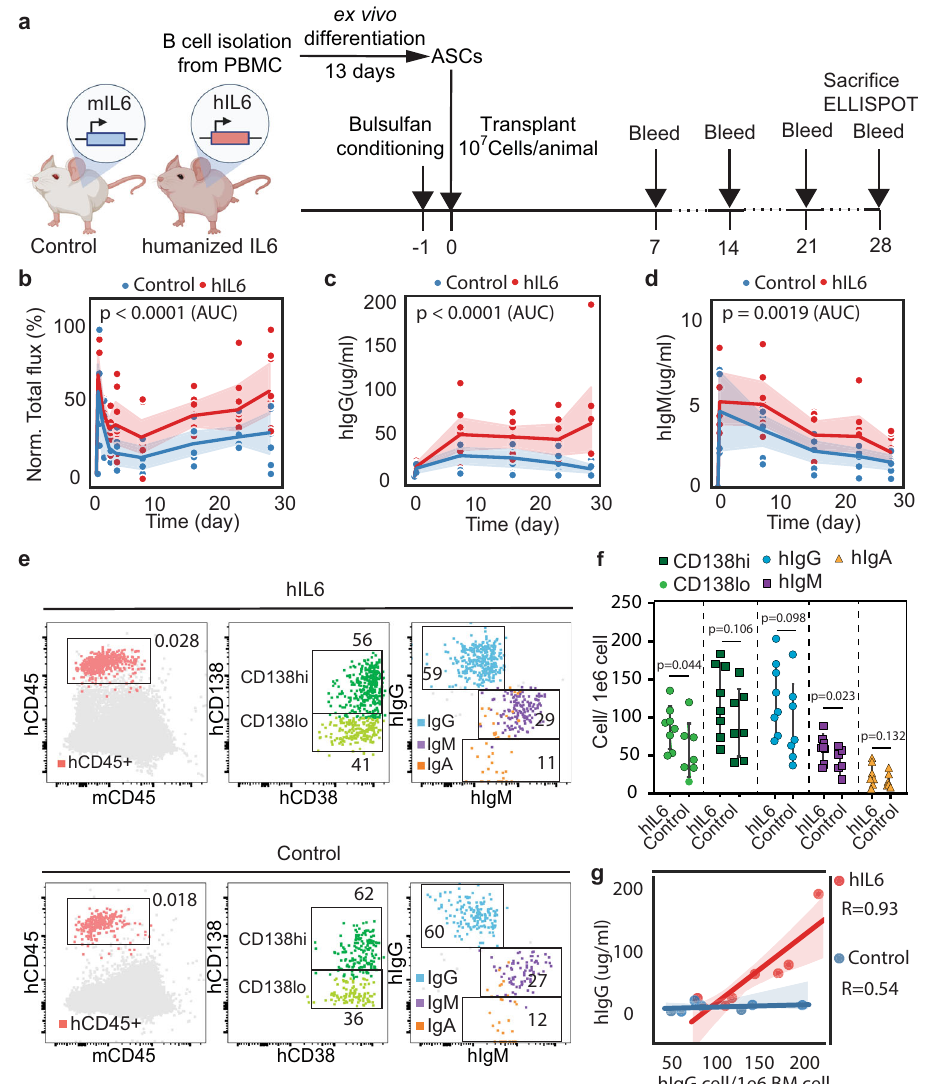
Fig.5|TransferofPCsintoanimmunode fi cientmousemodelexpressinghIL-6 improvesPCsengraftment.a Schematicdescribingthetransferofexvivo-derived PCs into B-NDG (control; n =7 animals from two independent experiments) and hIL-6-B-NDG knock-in (hIL-6; n =8 animals from two independent experiments) mice. It was partially created with BioRender.com. b – d Fire fl y luciferase was quanti fi ed by IVISimaging (normalized by Min-maxnormalization), hIgGand hIgM were quanti fi ed by ELISA and each point was plotted individually. The shadow represents the 95% con fi dence interval and the line represents the mean. P values were calculated in anunpaired two-sided t -test bycomparing the areaundercurve (AUC) from individual mice. P values for normalized fl ux AUC and IgG AUC are 1.46E-05 and 1.37E-05, respectively. Source data are provided as a Source Data fi le.